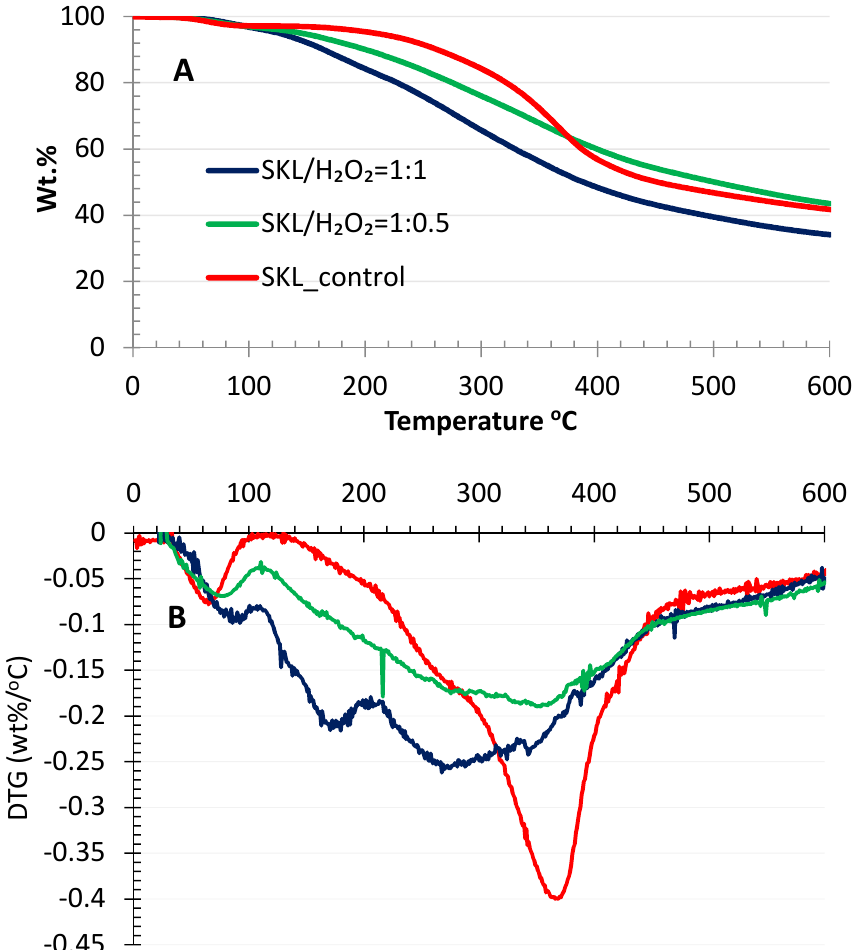
Figure 6. TGA curves ( A ) and DTG plots ( B ) of SKL and its de-polymerized products.